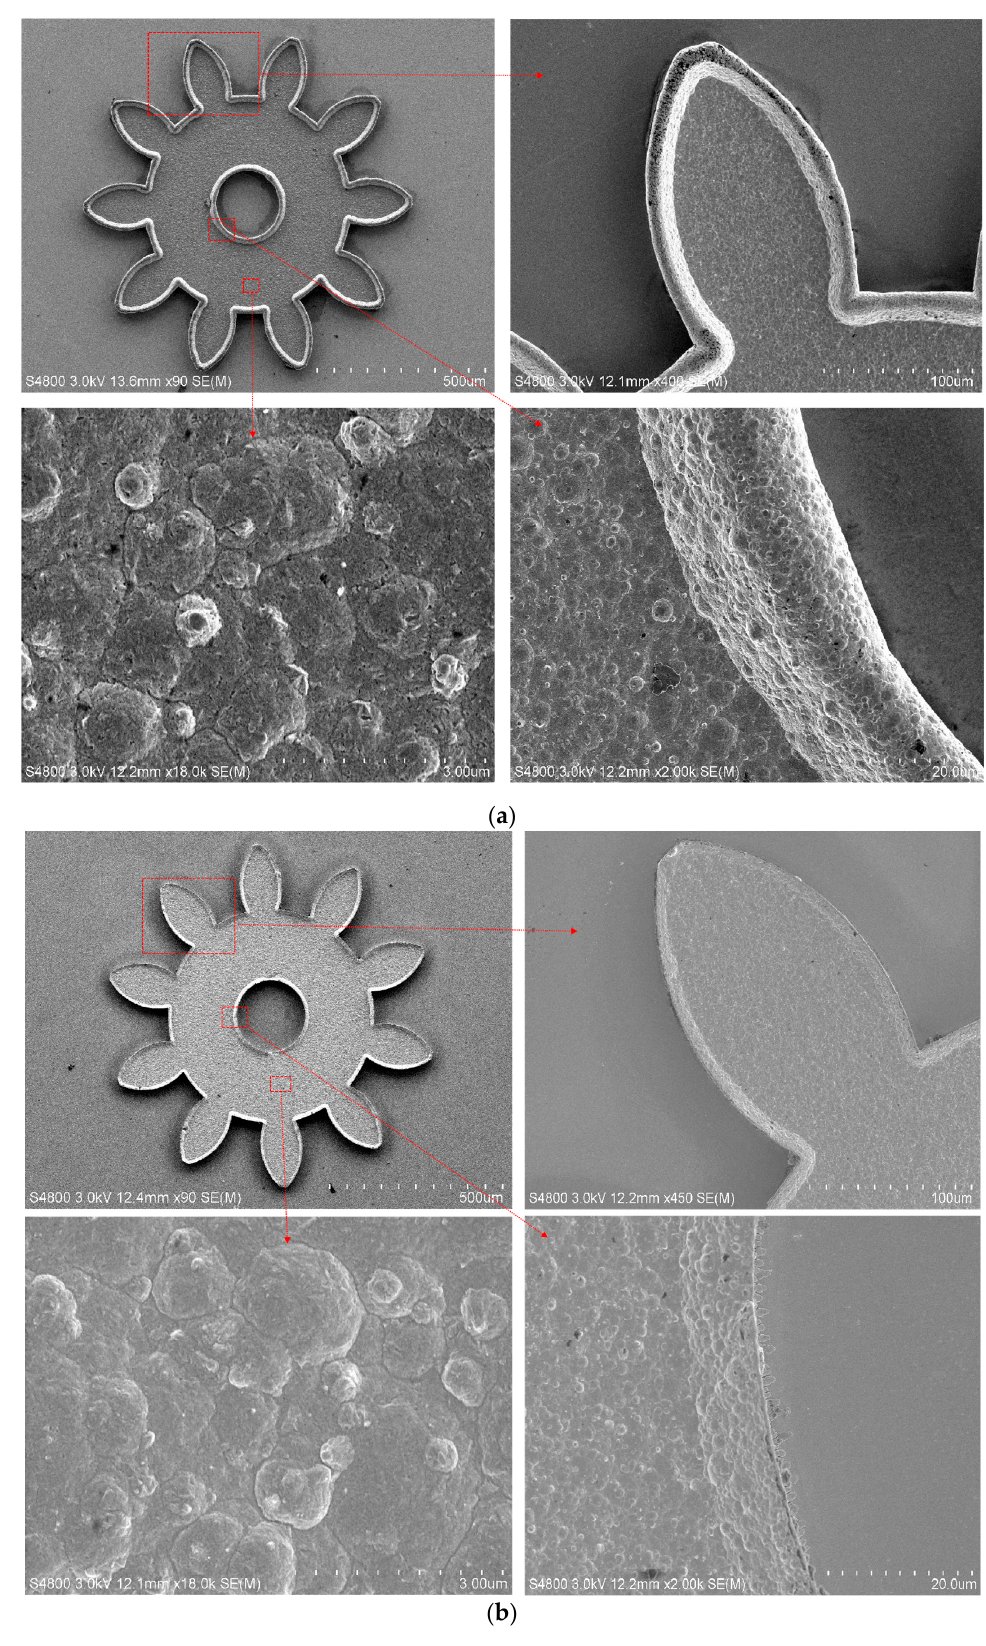
Figure 6. FE-SEM images of fabricated micro gear structures. ( a ) FE-SEM images in the traditional method; ( b ) FE-SEM images in the proposed